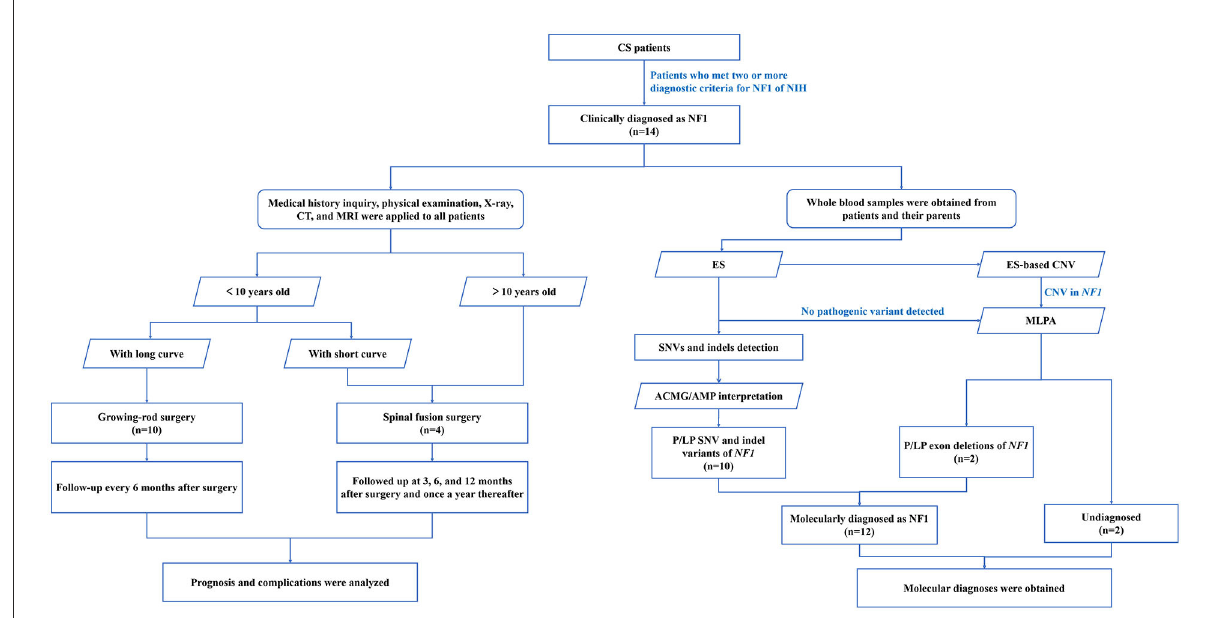
FIGURE1 Flow diagram of NF1 associated dystrophic scoliosis patients who were enrolled and received genetic testing. A total of 14 patients with the clinical diagnosis of NF1 associated dystrophic scoliosis were included. Medical history inquiry, physical examination, X-ray, CT, and MRI were applied to all patients to design the operation plan. Young patients with long curve accepted growing-rod surgery, young patients with short curve and older patients accepted spinal fusion surgery. After regular follow-up, prognosis and complications were analyzed. Whole blood samples were obtained from patients and their parents in parallel. Combination of ES and MLPA found 12 NF1 variants from 12 patients. ES, exome sequencing; MLPA, multiplex ligation-dependent probe amplification; SNV, single nucleotide variants; indels, insertion-deletions; P,